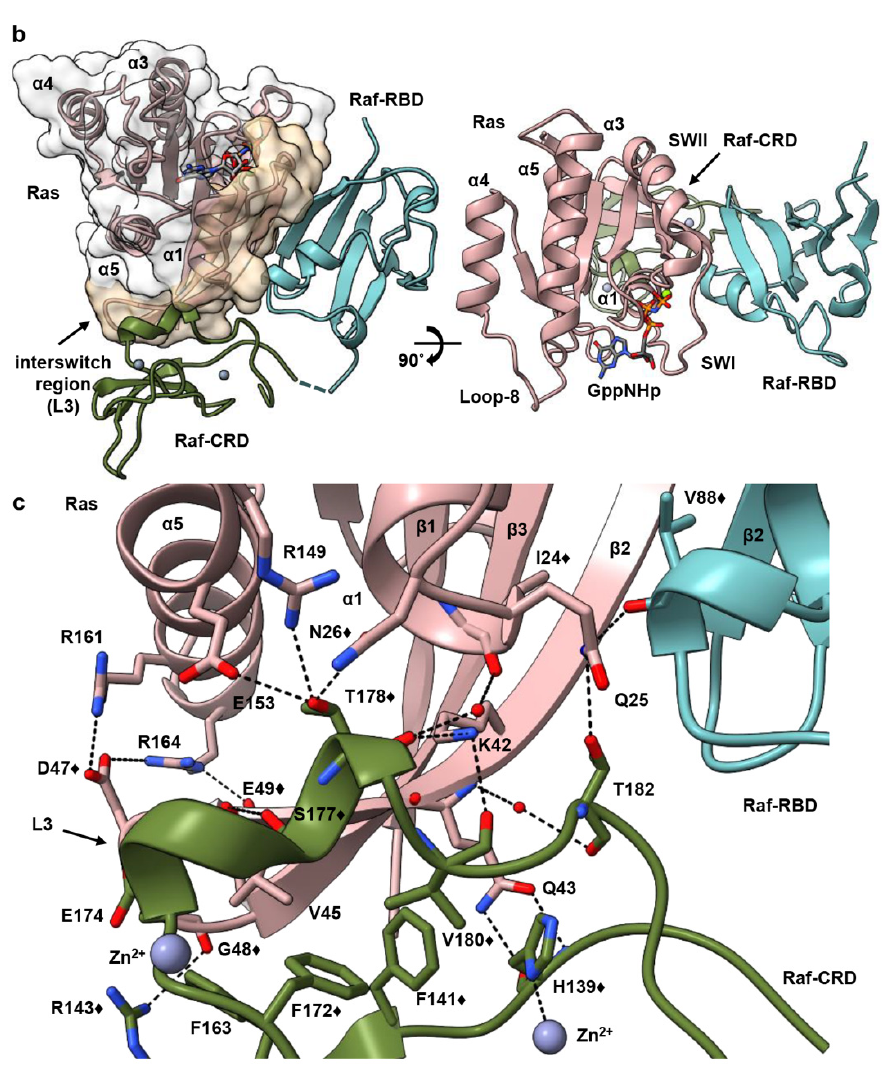
Figure 1. Structure of the HRas–CRaf-RBD_CRD complex. ( a ) Schematic diagrams of HRas and CRaf provide structural boundaries for the Ras G domain and hypervariable region, and the three conserved regions found in Raf kinases. ( b ) Cartoon and surface representations of the HRas–CRaf-RBD_CRD complex reveal a continuous binding surface spanning Ras (pink), residues 23 through 48 for both the Raf-RBD (teal), and Raf-CRD (green). ( c ) The Raf-CRD interacts with residues in Ras α 1, α 5 and the interswitch region through hydrogen bonds and hydrophobic contacts. The symbol ♦ identifies residues that show chemical shift perturbations in the analysis described by Feng et al. [24].